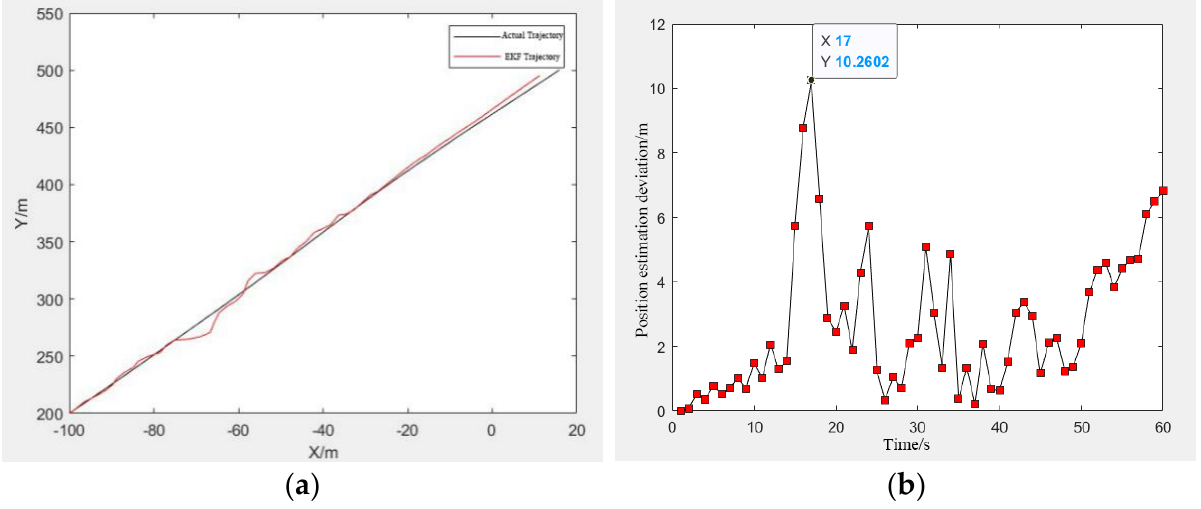
Figure 13. Target tracking result based on EKF algorithm. ( a ) Predicted trajectory based on EKF. ( b ) The estimated deviation.